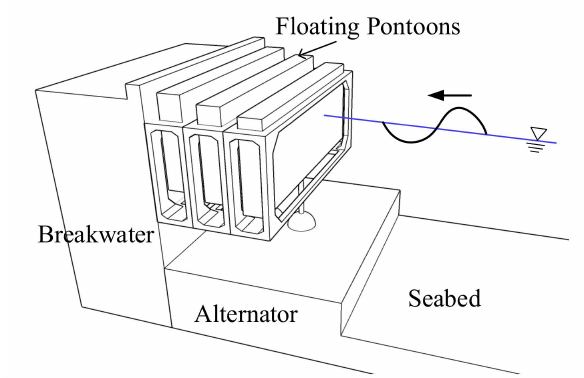
Figure 1. Schematic diagram of the hybrid system combining a fixed breakwater and a wave energy